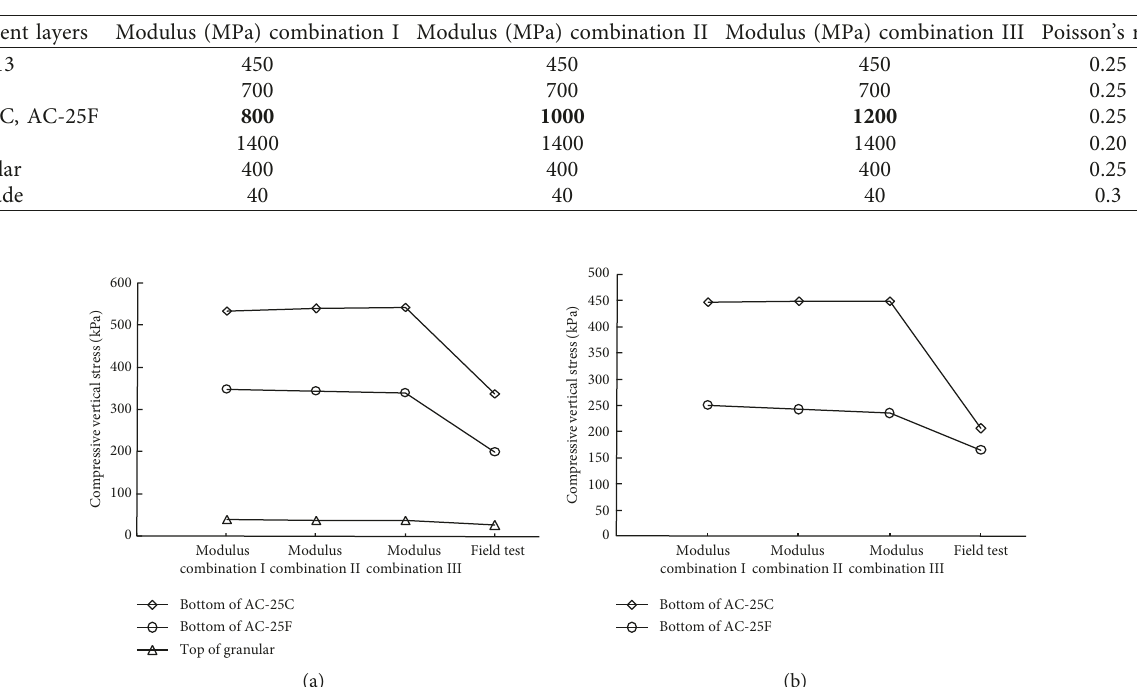
Table 3: Static modulus.